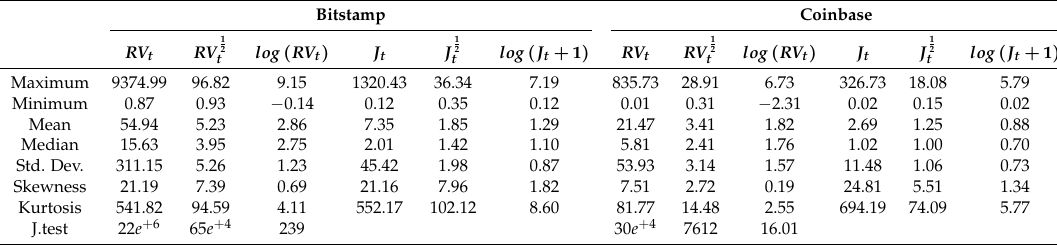
Table 5. Summary statistic for the realized variance, realized standard deviation and logarithmic realized variance. Panel (A) reports results for the full sample while panel (B) for the Hype period. The rwo J.test reports the Jarque-Bera test statistics for the null hypothesis of Gaussianity. Panel ( A ) —Full sample